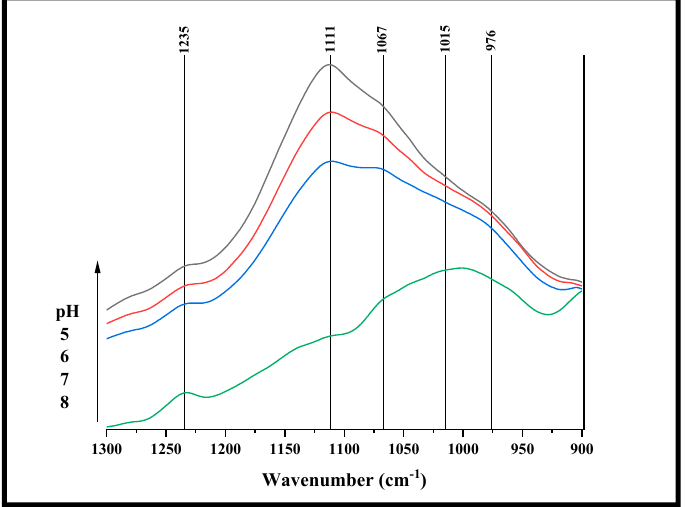
Figure 3. In situ ATR-FTIR spectra of hematite-adsorbed 5 µM Sb (V) collected at pH values 5–8.